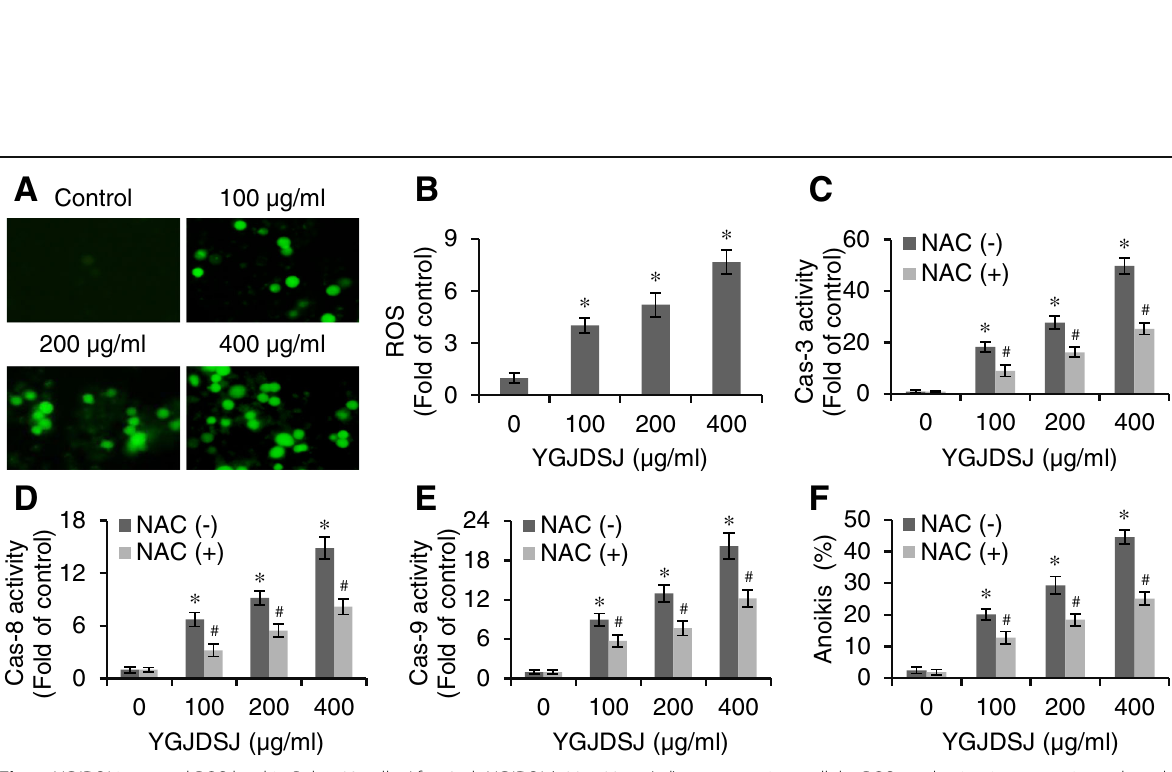
Fig. 4 YGJDSJ increased ROS level in Bel-7402 cells. After 24 h YGJDSJ (100 – 400 μ g/ml) treatment, intracellular ROS production in